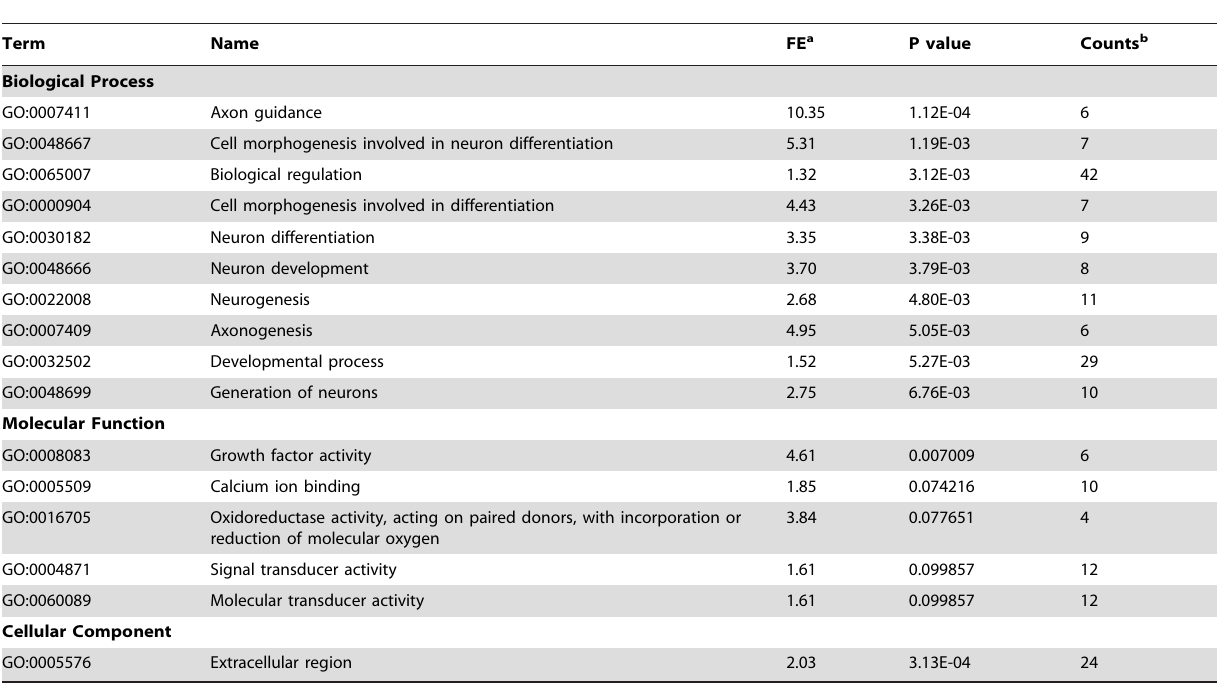
Table 3. GO Enrichment analysis with enrichment for all three GO categories.